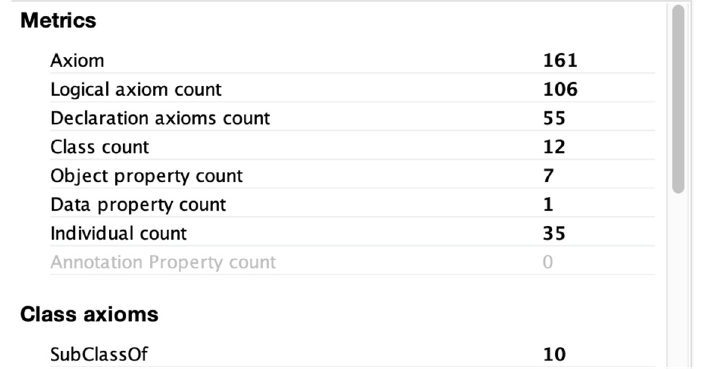
Figure 16. Results of verification cycle.